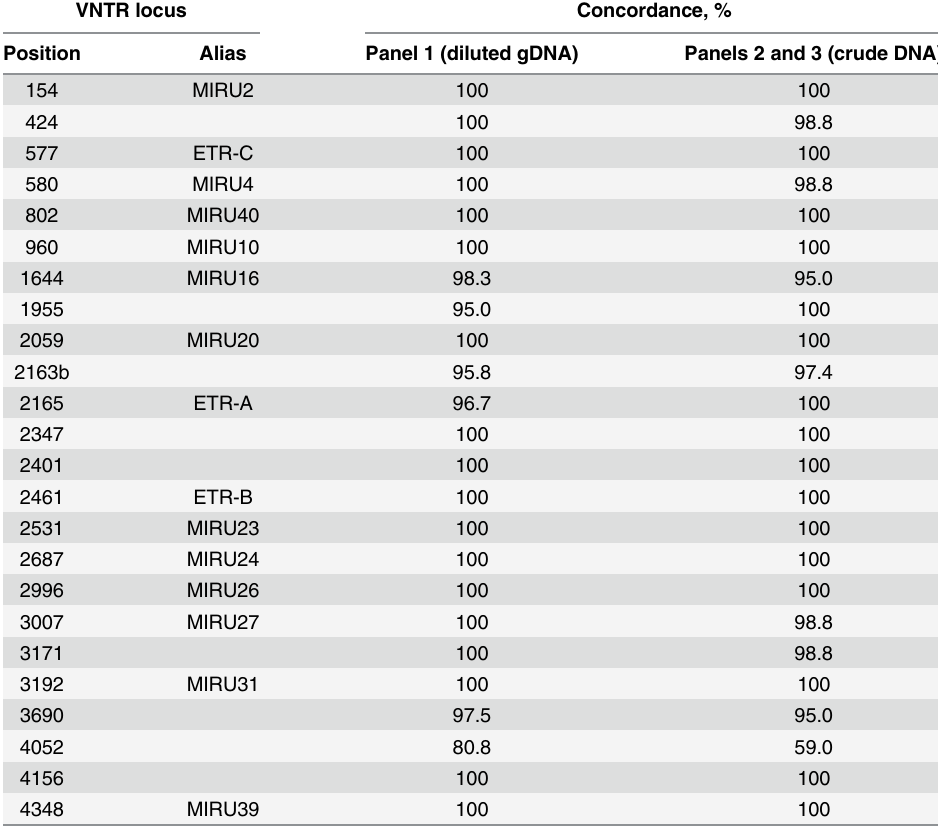
Table 1. Combined agreement rates between QiaXcel and reference methods. VNTR